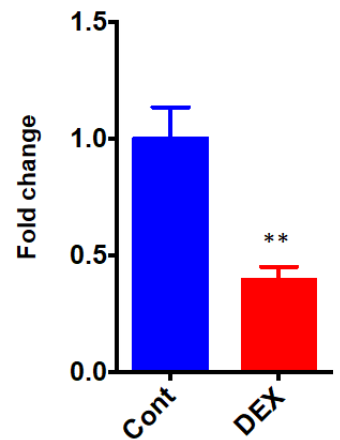
Figure 7. qRT-PCR of Dusp1. Cont: control group, DEX: dexmedetomidine group. N = 5 in each group. ** p < 0.01.